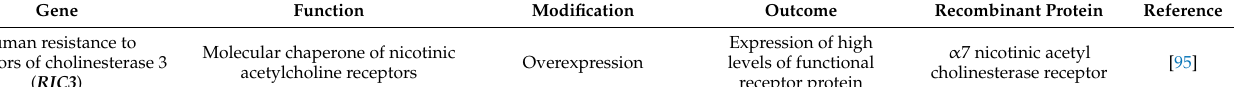
Table 6. Genes that have been engineered to improve recombinant protein folding in the HEK293 cell line. Gene Function Modification Outcome Recombinant